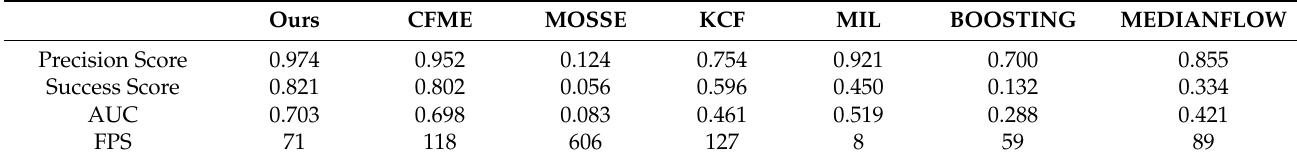
Figure 11. Precision plot and success plot. The values in legends are the AUC. ( a ) Precision plot of video5. ( b ) Success plot of video5. Table 7. The results of video5.